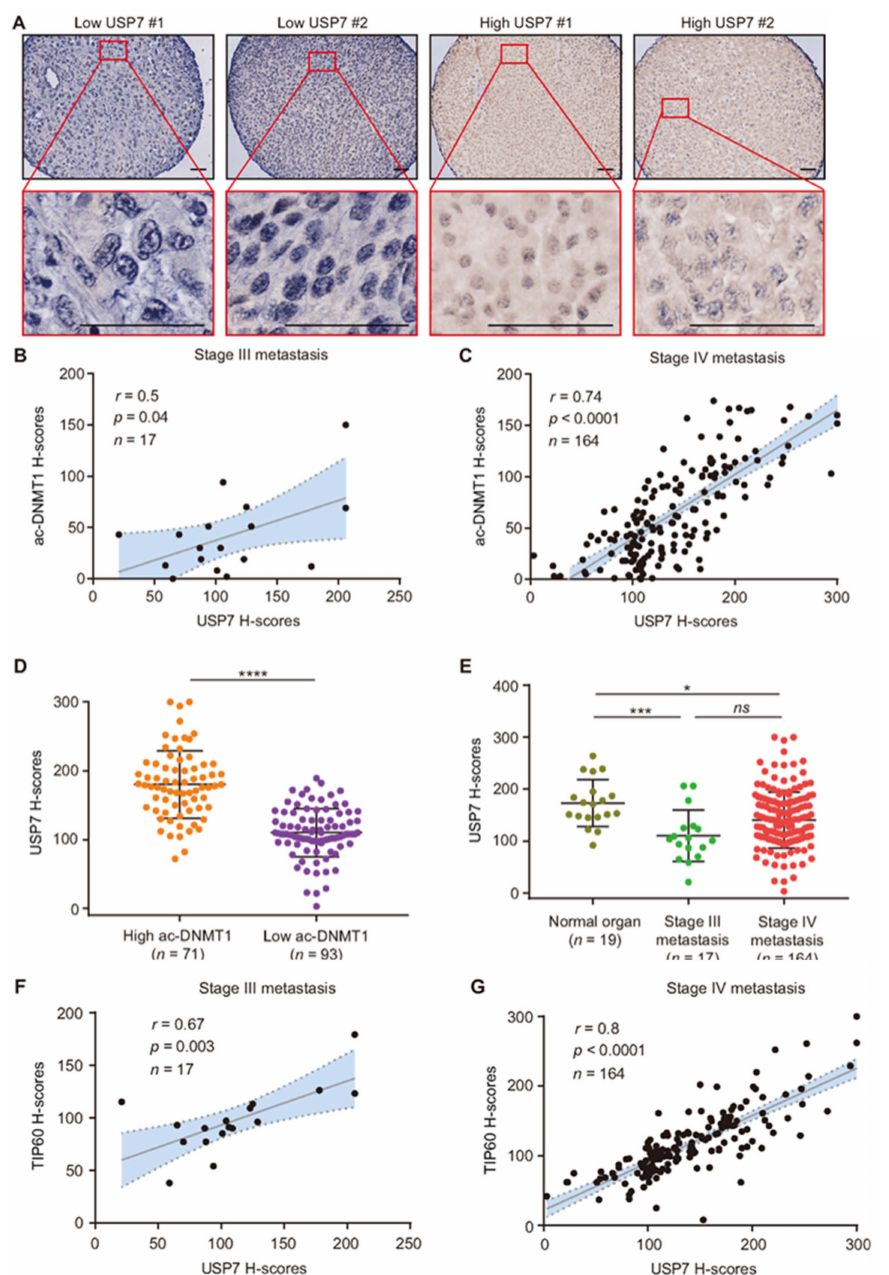
Figure 5. Ac-DNMT1 and USP7 protein levels positive correlate in metastatic melanoma. ( A ) Represe- ntative IHC images of USP7 in the TMA melanoma cohort. Scale bars = 20 µ m. ( B , C ) Correlation between USP7 and ac-DNMT1 protein levels in stage III ( B ) or stage IV ( C ) metastatic FFPE tissues. ( D ) Comparison of USP7 H-scores in stage IV patients with high or low ac-DNMT1 protein levels. ( E ) Comparison of USP7 H-scores in normal organ tissues, stage III, and stage IV metastasis from the TMA melanoma cohort. ( F , G ) Correlation between USP7 and TIP60 protein levels in stage III ( F ) or stage IV ( G ) metastatic FFPE tissues. The best-fit line (straight line) and the 95% CI (dotted line) are shown in grey. Data represent the mean ± SD. ns : not significant, * p < 0.05, *** p < 0.001, and **** p <